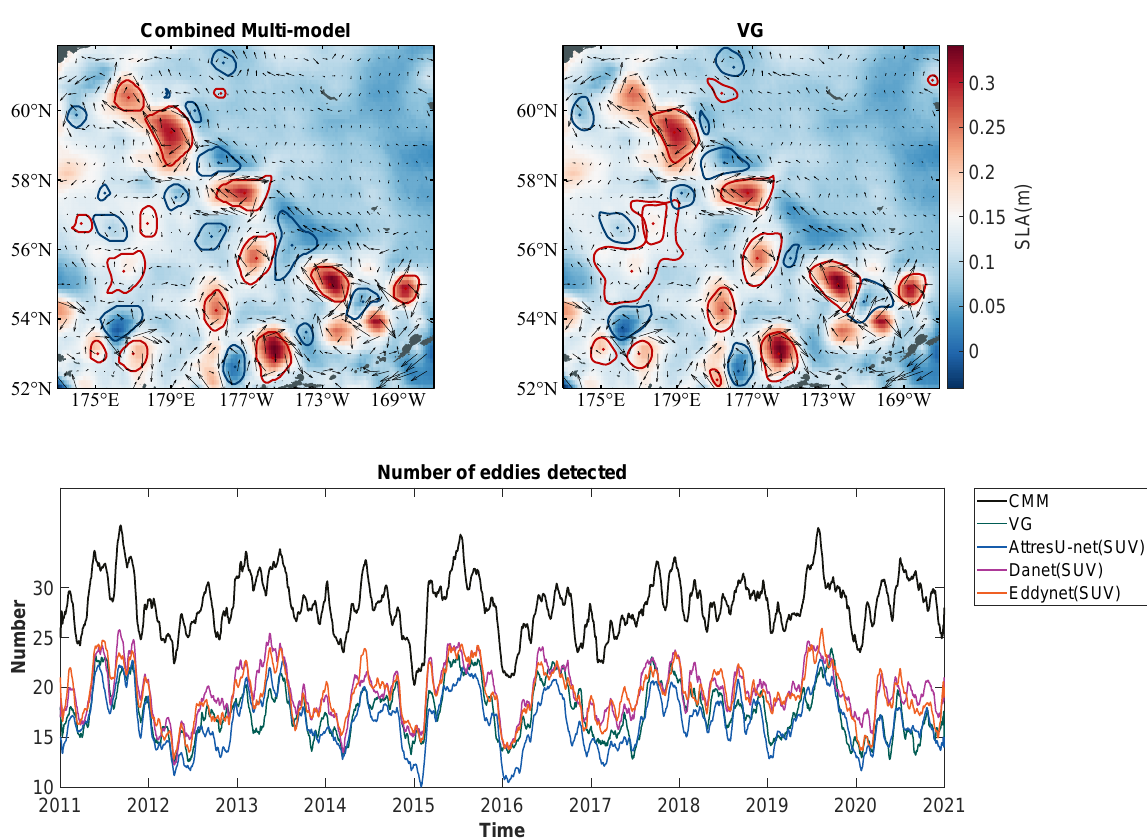
Figure 4. Combination of multi-model eddy detection results. The upper panel shows a snapshot (9 September 2016) of the comparison of multi-model recognition results with those of the VG algorithm. Red (blue) dots represent the center of an anticyclone (cyclone). The bottom panel shows the number of eddies detected by the CMM compared with the other algorithms in this paper. The curve represents the results after 31-day